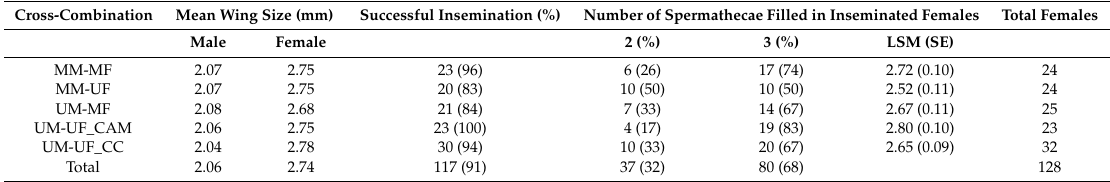
Table 1. Mean wing size (mm), insemination success and spermathecae filled for di ff erent cross-combinations of marked and unmarked Aedes aegypti males and females. LSM: least squares mean, SE: standard error.